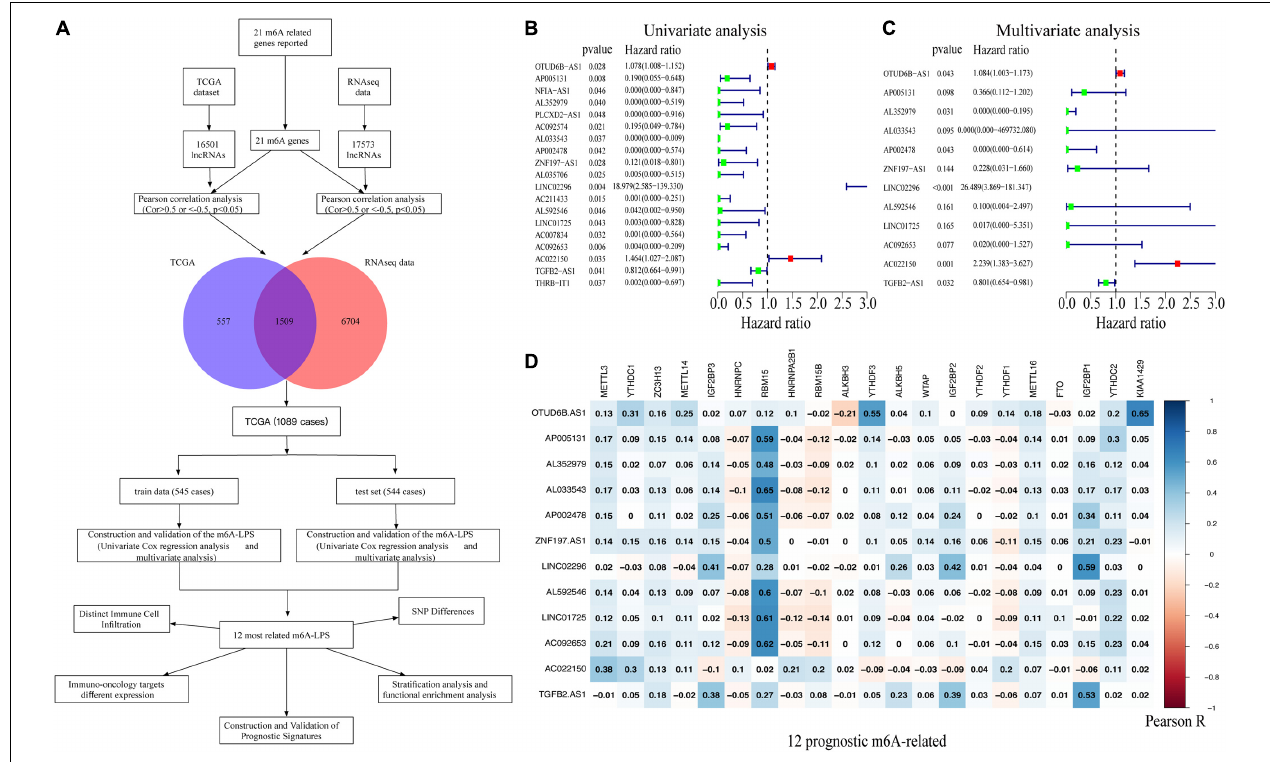
FIGURE 1 | (A) Study flowchart. (B,C) Forest plots of m 6 A-related lncRNAs associated with prognosis via univariate and multivariate analyses. (D) Heatmap of the correlations between m 6 A-related genes and the 12 prognostic m 6 A-related lncRNAs. m 6 A-related lncRNAs, N 6 -methyladenosine-related long non-coding